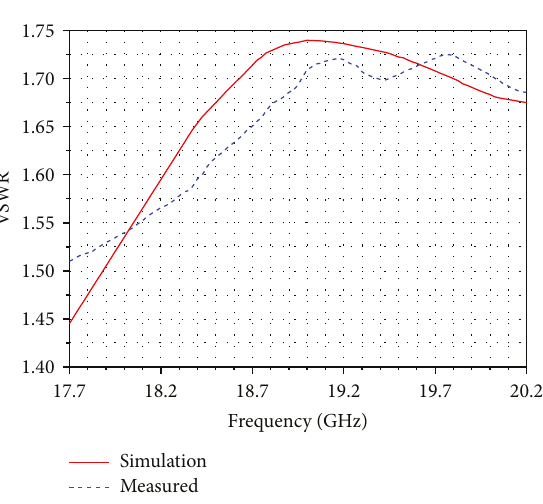
Figure 7: Curve of receiving VSWR.